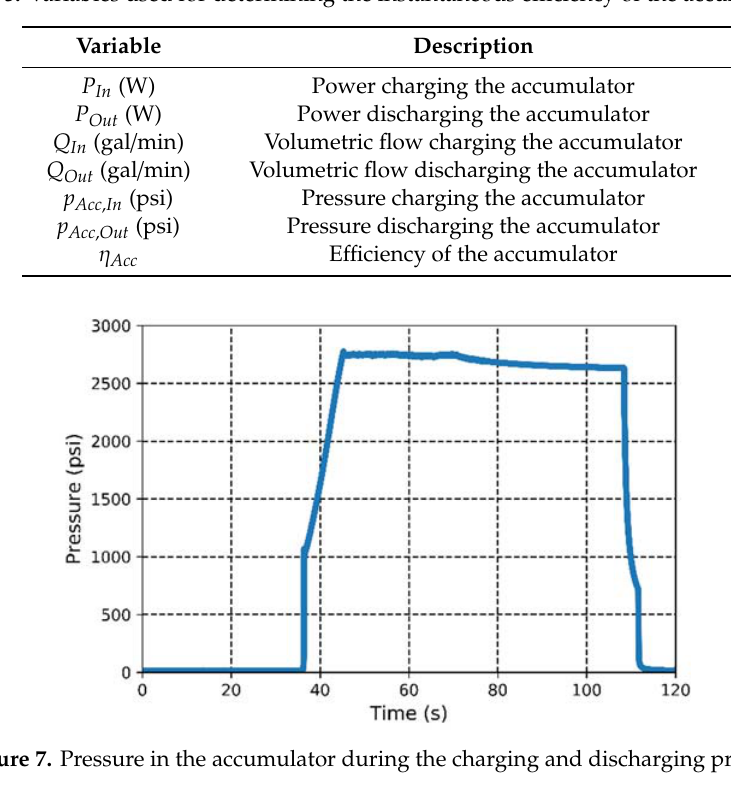
Table 5. Variables used for determining the instantaneous e ffi ciency of the accumulator.